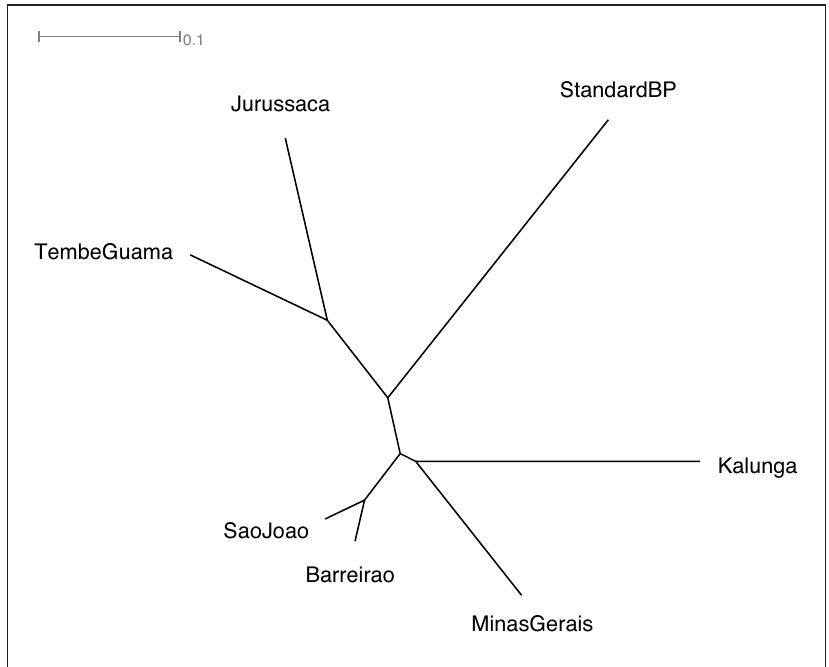
Figure 3: Split tree of a Neighbour-Joining Tree based on 45 morphosyntatic features of seven Brazilian Portuguese varieties.